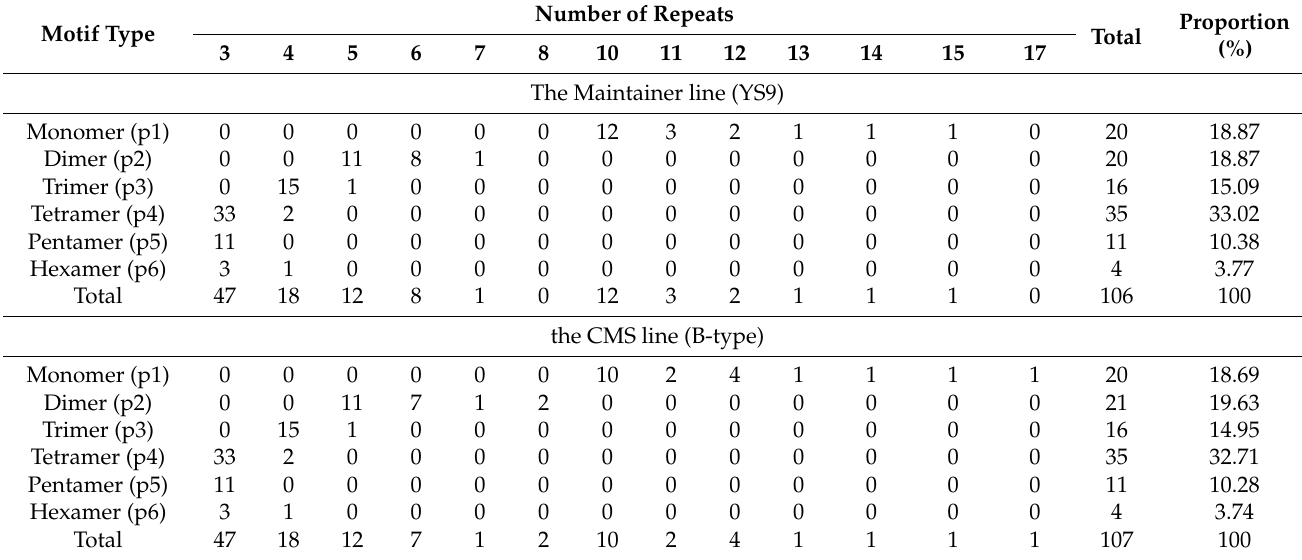
Table 3. Frequency of identified SSR motifs in YS9 and B